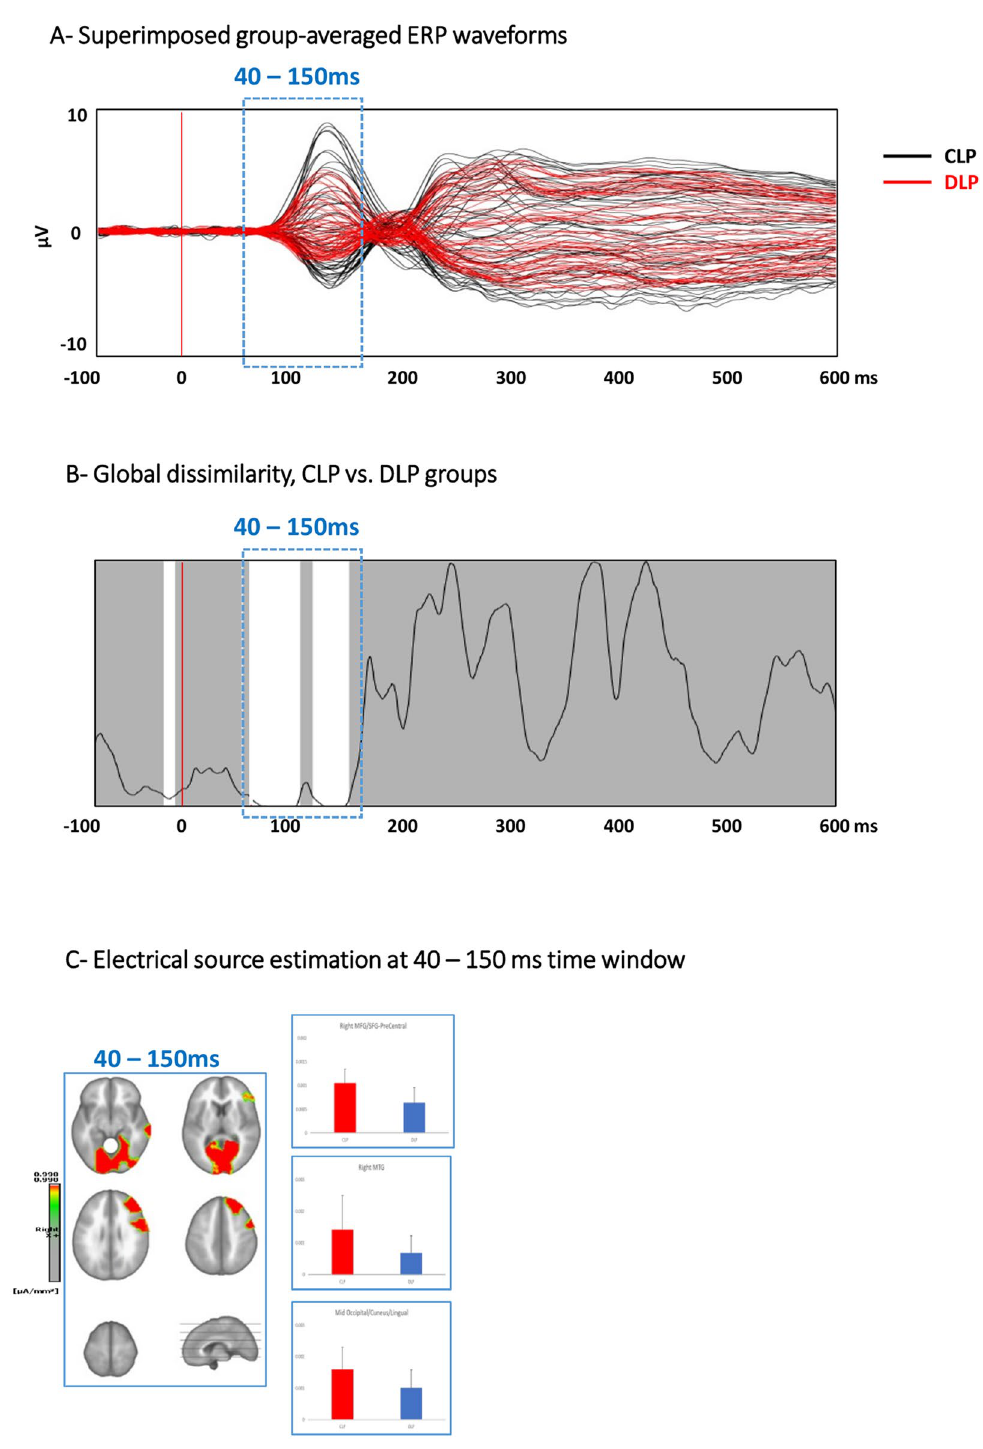
Figure 4. Electrical neuroimaging results: Nonlinguistic switching task; ( A ) Superimposed group-averaged ERP waveform of all conditions of interest. ( B ) Global dissimilarity analysis. This analysis showed a significant difference between CLP and DLP at 40 to 150 ms poststimulus presentation. ( C ) Electrical source estimation at the significant time